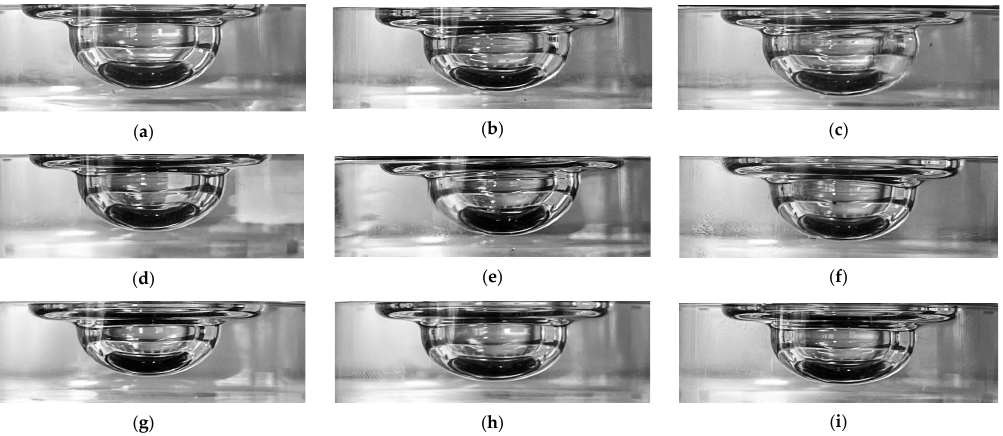
Figure 10. Comparison of the experimental results. ( a ) v = 11 m/s, η = 500 Pa·s, ( b ) v = 12 m/s, η = 500 Pa·s, ( c ) v = 13 m/s, η = 1000 Pa·s, ( d ) v = 11 m/s, η = 1000 Pa·s, ( e ) v = 12 m/s, η = 1000 Pa·s, ( f ) v = 13 m/s, η = 1000 Pa·s, ( g ) v = 11 m/s, η = 2000 Pa·s, ( h ) v = 12 m/s, η = 2000Pa·s, ( i ) v = 13m/s, η = 2000 Pa·s.